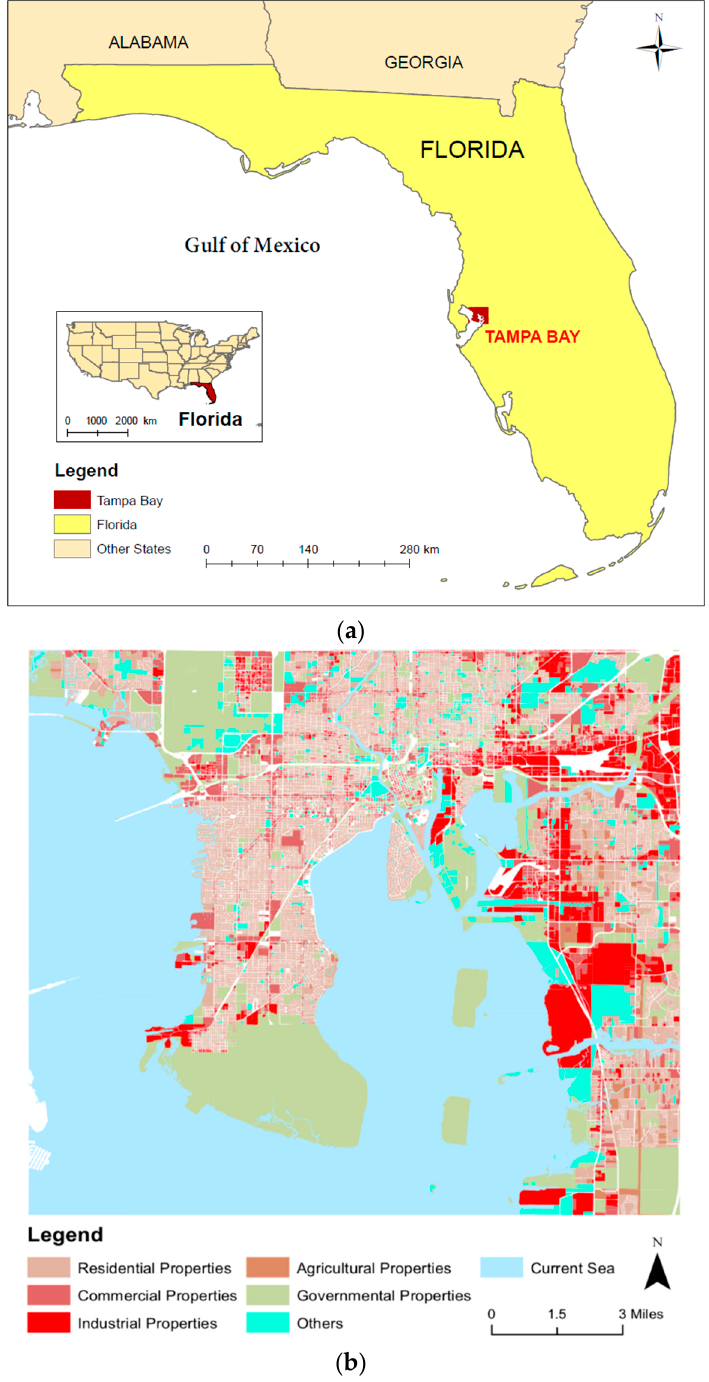
Figure 1. Parcel-level property map of the studied area: ( a ) The location of Tampa Bay, Hillsborough County, Florida, ( b ) Six types of properties.